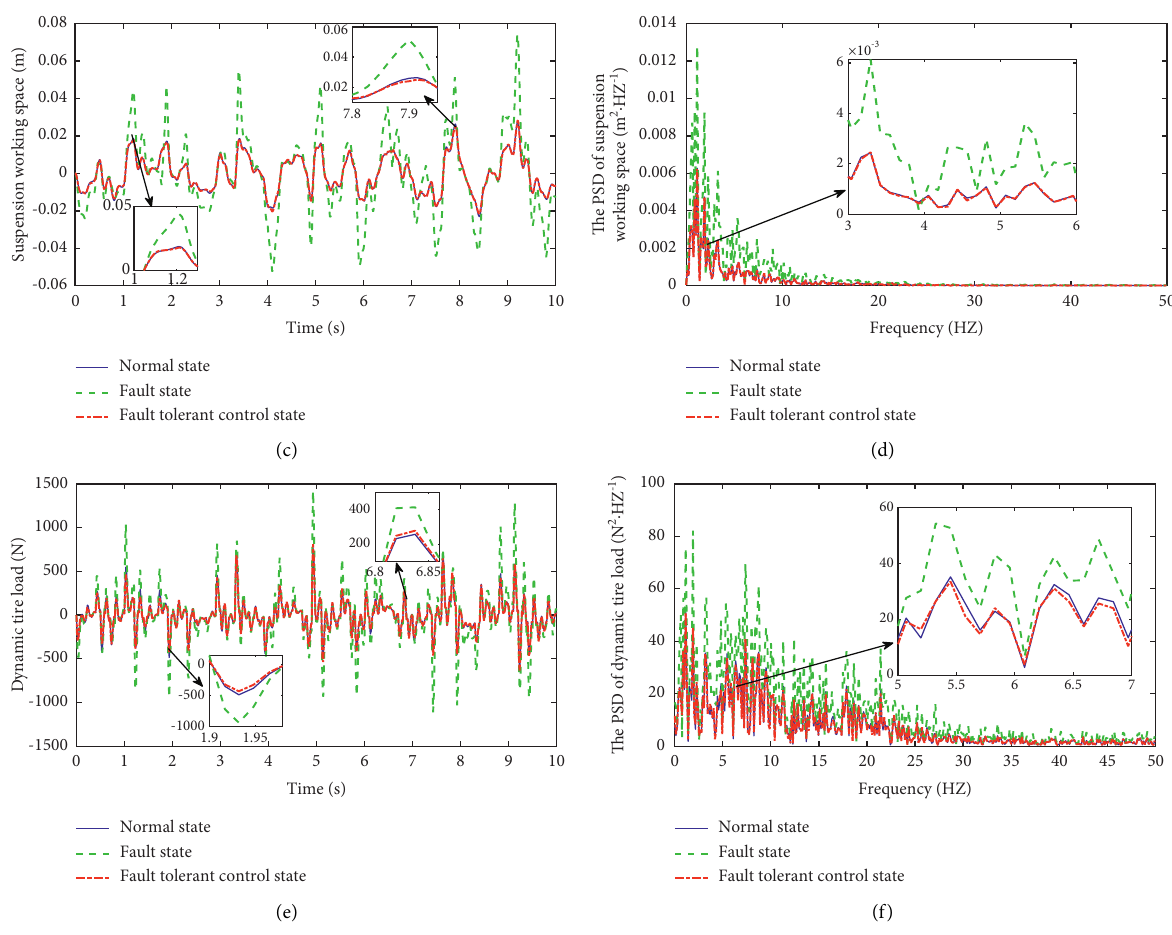
Figure 14: Comparison chart of suspension performance under random road. (a) Time-domain responses of sprung mass acceleration. (b) Frequency-domain responses of sprung mass acceleration. (c) Time-domain responses of suspension working space. (d) Frequency-domain responses of suspension working space. (e) Time-domain responses of dynamic tire load. (f) Frequency-domain responses of dynamic tire load. Table 5: The output RMS values in time domain under random road.